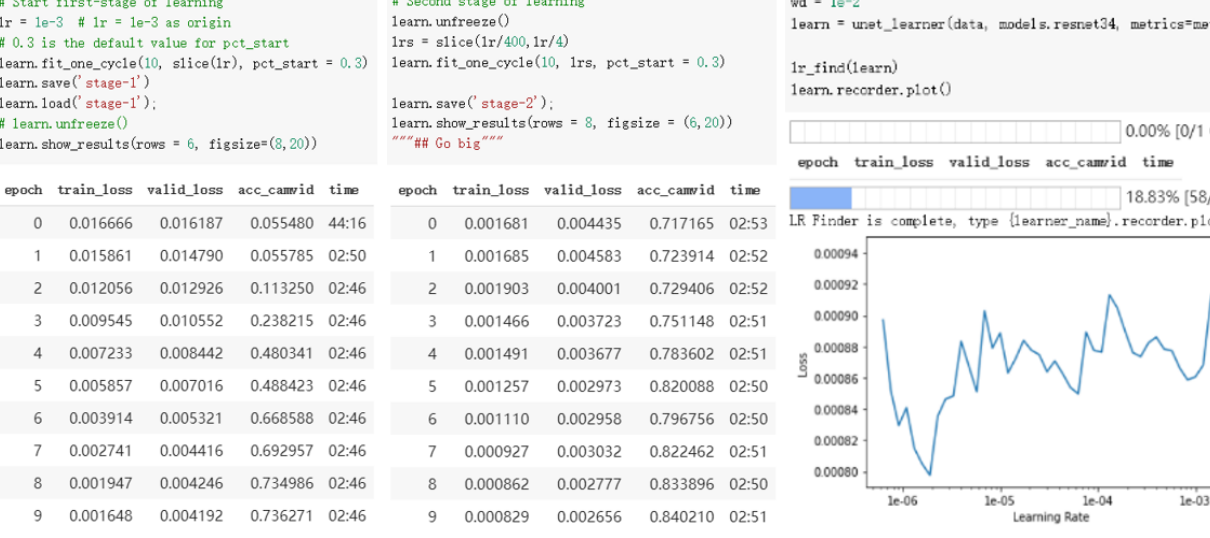
Figure 5. Sample results of two-stage learning approach and the generated curve to find an optimal learning rate (after parameter tuning) on semantic image segmentation for online VEDAI.